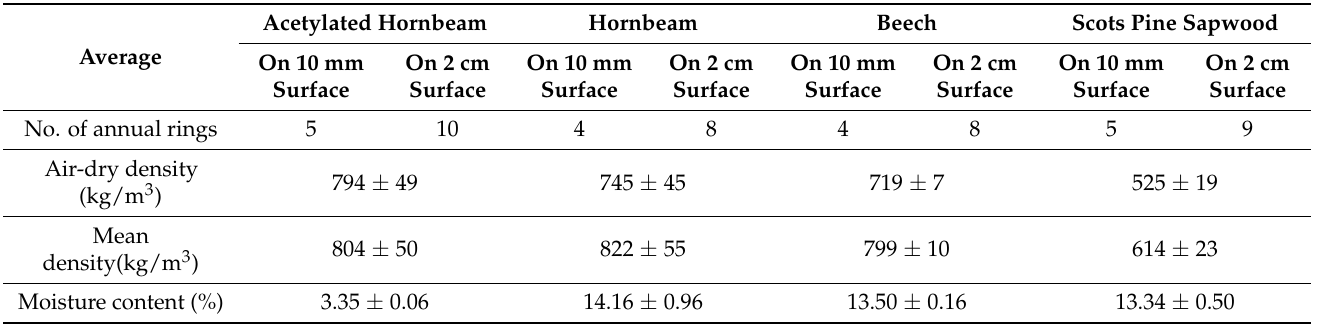
Table 1. Information about the